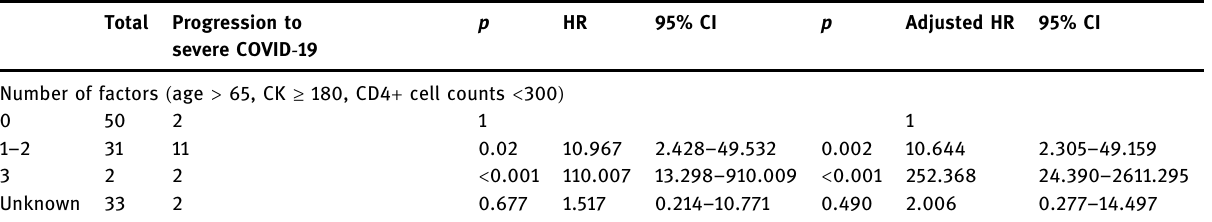
Table 6: Independent risk factors for progression to severe COVID -